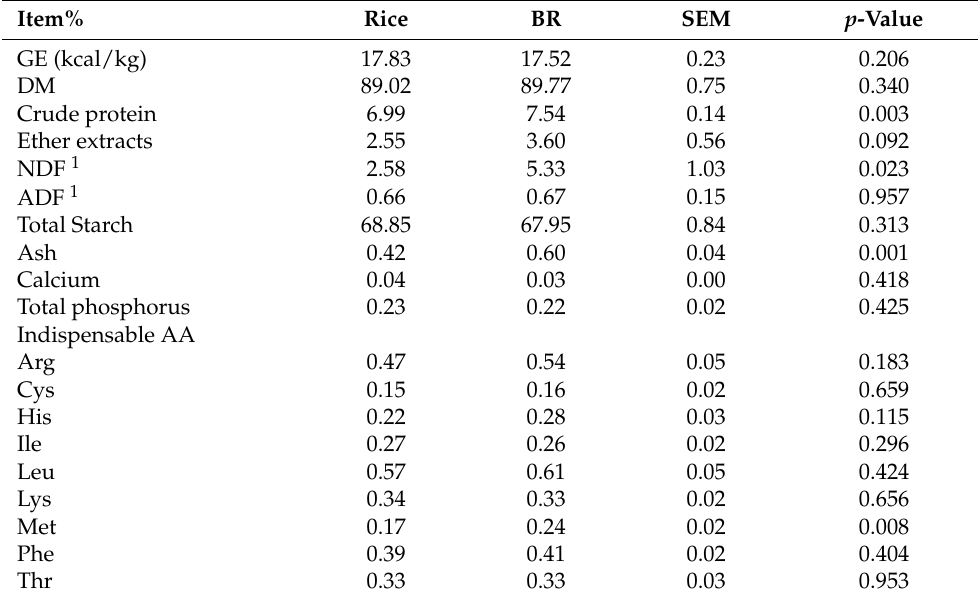
Table 5. Comparison of nutrition and amino acid of rice and BR